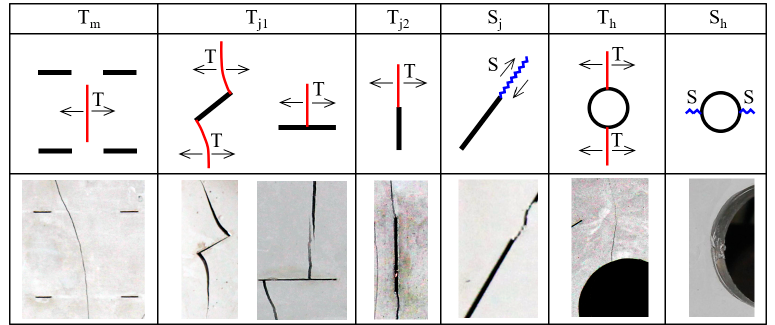
Figure 5. Young’s modulus vs. two geometrical parameters of the laboratory tests. ( a ) E vs. β ; ( b ) E vs. k .